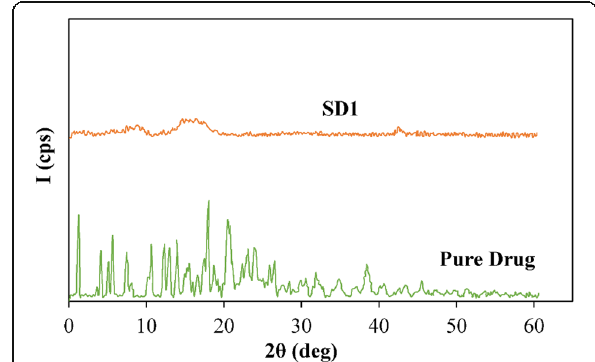
Fig. 5 X-ray diffractogram of pure drug and SD1 formulation